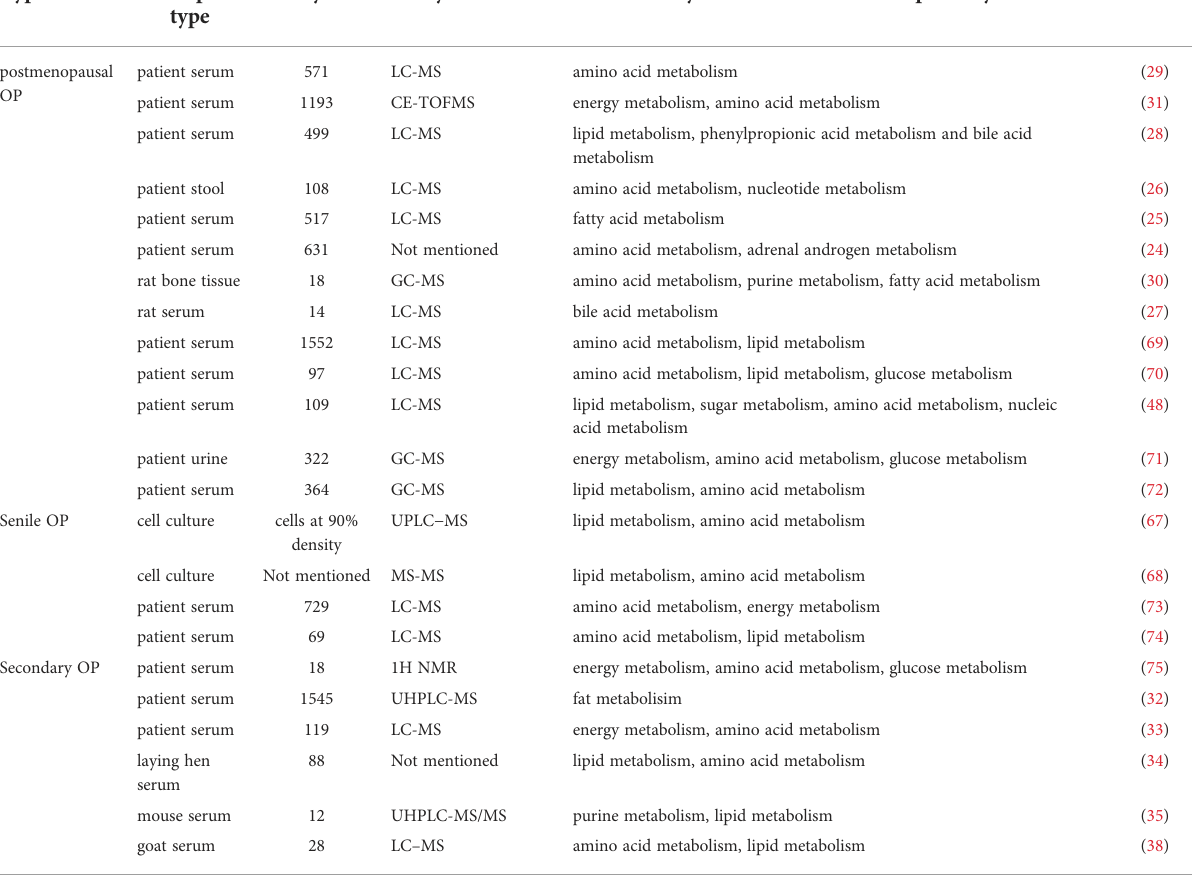
TABLE 1 The application of metabolomics in exploring the pathogenic mechanism of various types of